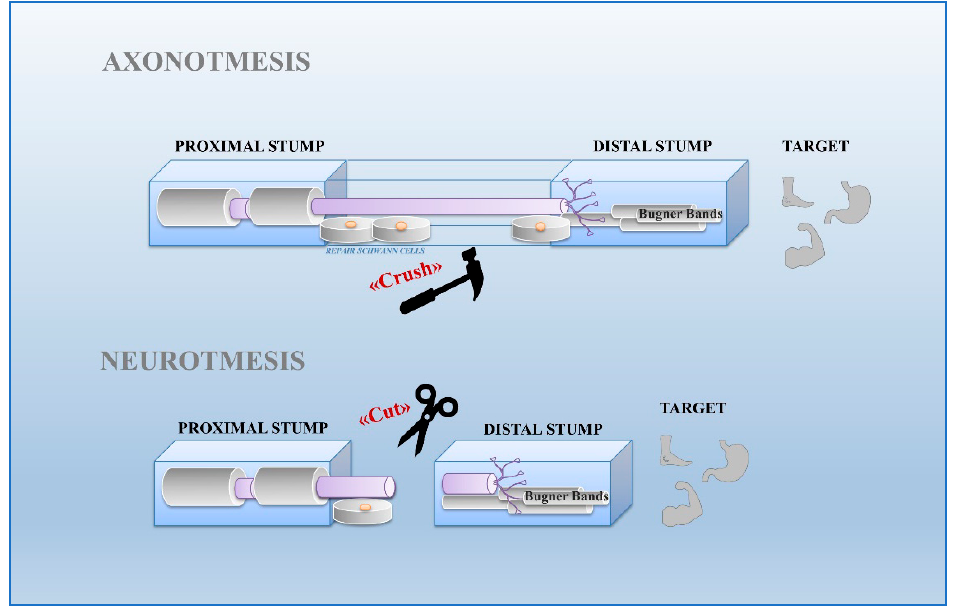
Figure 1. Nerve regeneration in axonotmesis and neurotmesis. Axonotmesis consists in destruction of axons by nerve crush. Axons are severed but remain within intact tubes. Schwann cells of the bridge accompany axon regeneration to the Bungner band in the distal stump towards the target organ. Neurotmesis is characterized by the destruction of axons following a cut lesion. Schwann cells of proximal stump drive the regenerating fibers towards the Bungner band of the distal stump.